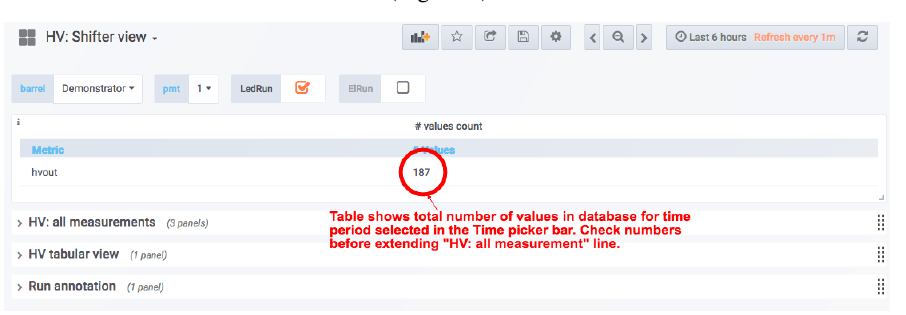
Figure 4. “HV: Shifter view” dashboard.